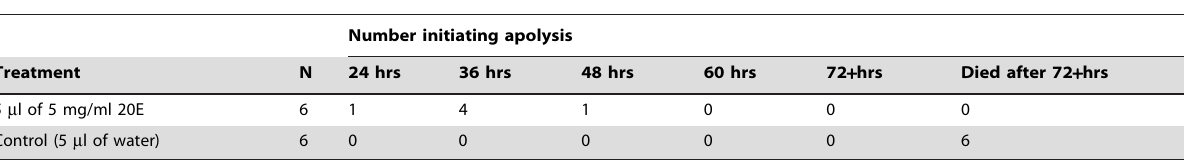
Table 1. The effect of 20-hydroxyecdysone injection on starved 4 th instar